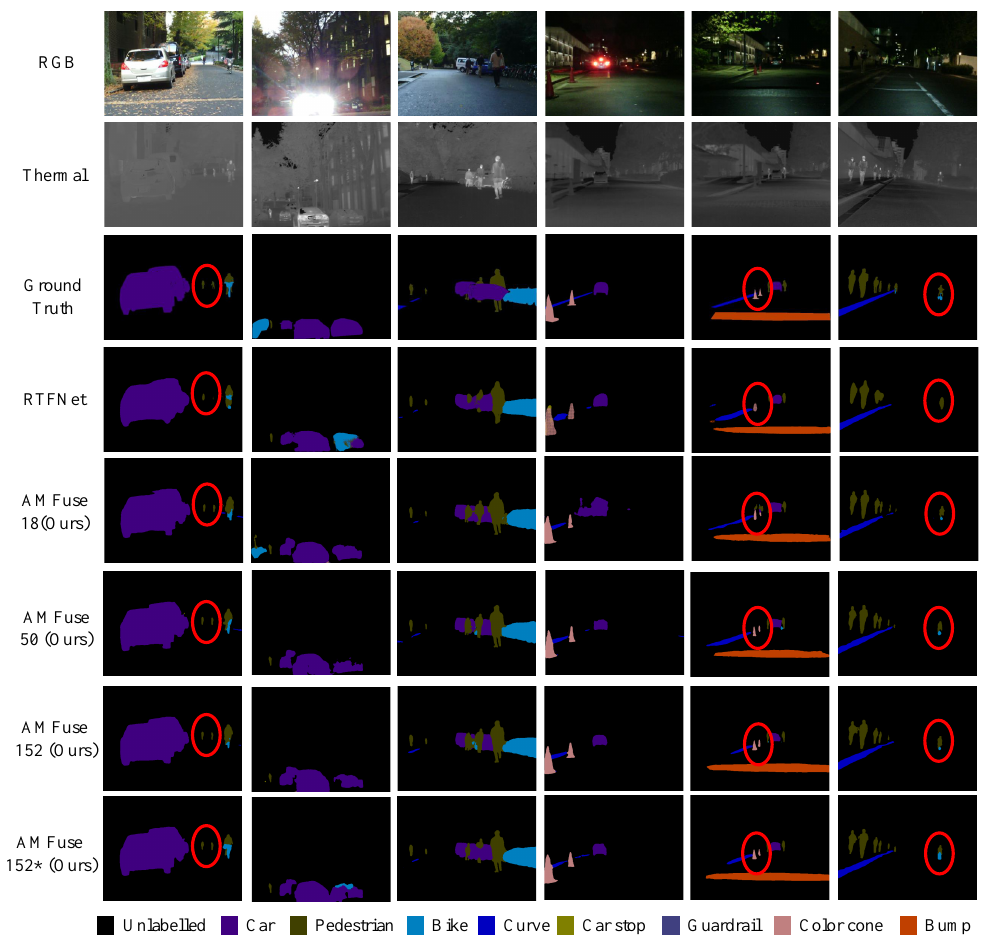
Figure 8. The sample qualitative demonstrations of multi-spectral semantic segmentation in the urban scenes. The left three and right three columns display the segmentation results with typical lighting conditions in the daytime and nighttime, respectively. The figure is best viewed in